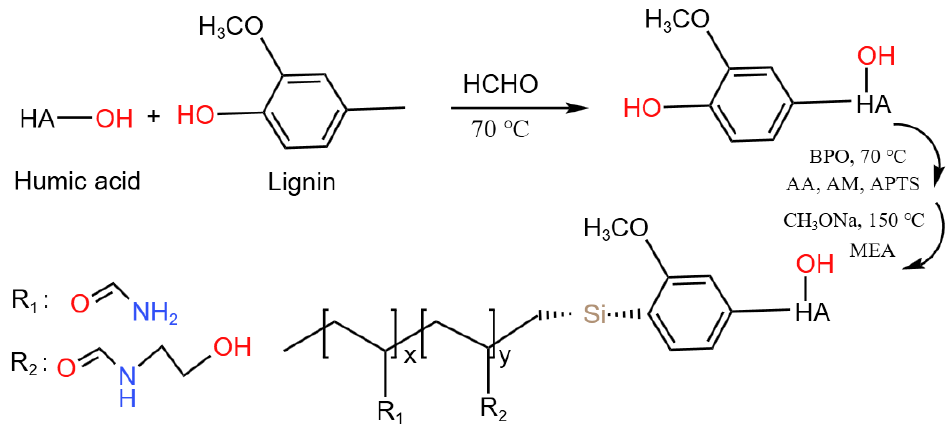
Figure 2. Synthesis route of VR-H.